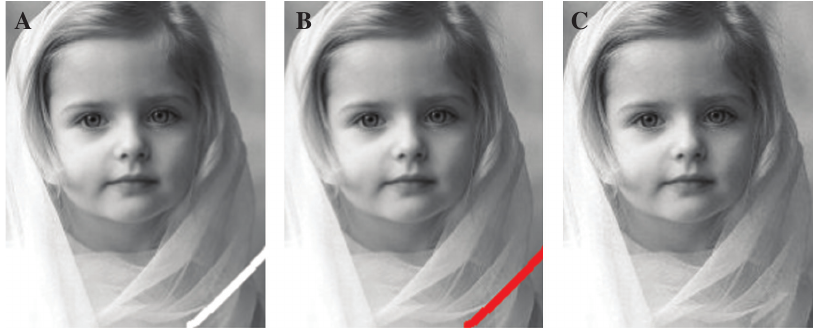
Figure 7. Nice1: Patch Size 9 ×